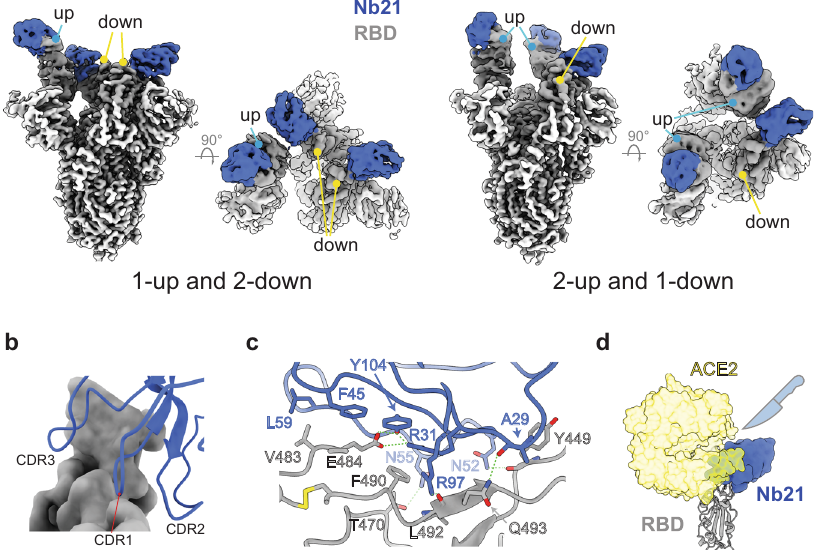
Fig. 2 Structure of an ultrapotent class I Nb (21). a Cryo-EM structure of the Nb21:S complex reveals 1-up and 2-down RBD conformations. b The involvement of three CDRs of Nb21 for RBD binding. c Additional Nb21:RBD interactions: side chains of R97, N52, and N55 (Nb21) form hydrogen bonds with the main chain carbonyl groups of L492 and Y449 and the side chain of T470 (RBD), respectively. The main-chain carbonyl group of A29 (Nb21) also forms a hydrogen bond with Q493 (RBD). Besides these polar interactions, F45 and L59 of Nb21 and V483 of RBD form a cluster of hydrophobic interactions, together, providing ultrahigh-af fi nity and selectivity for RBD binding. d Structural overlap of hACE2 with Nb21:RBD complex.